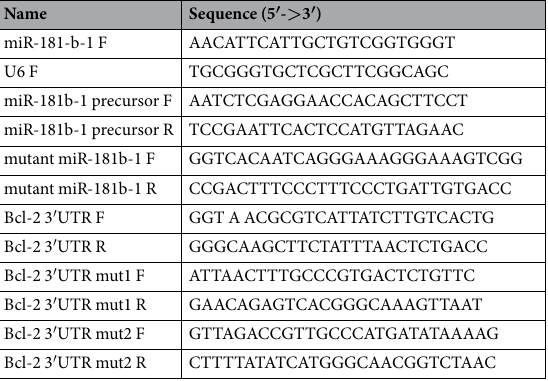
Table 1. The oligonucleotides sequence used in the study F: forward primer; R: reverse